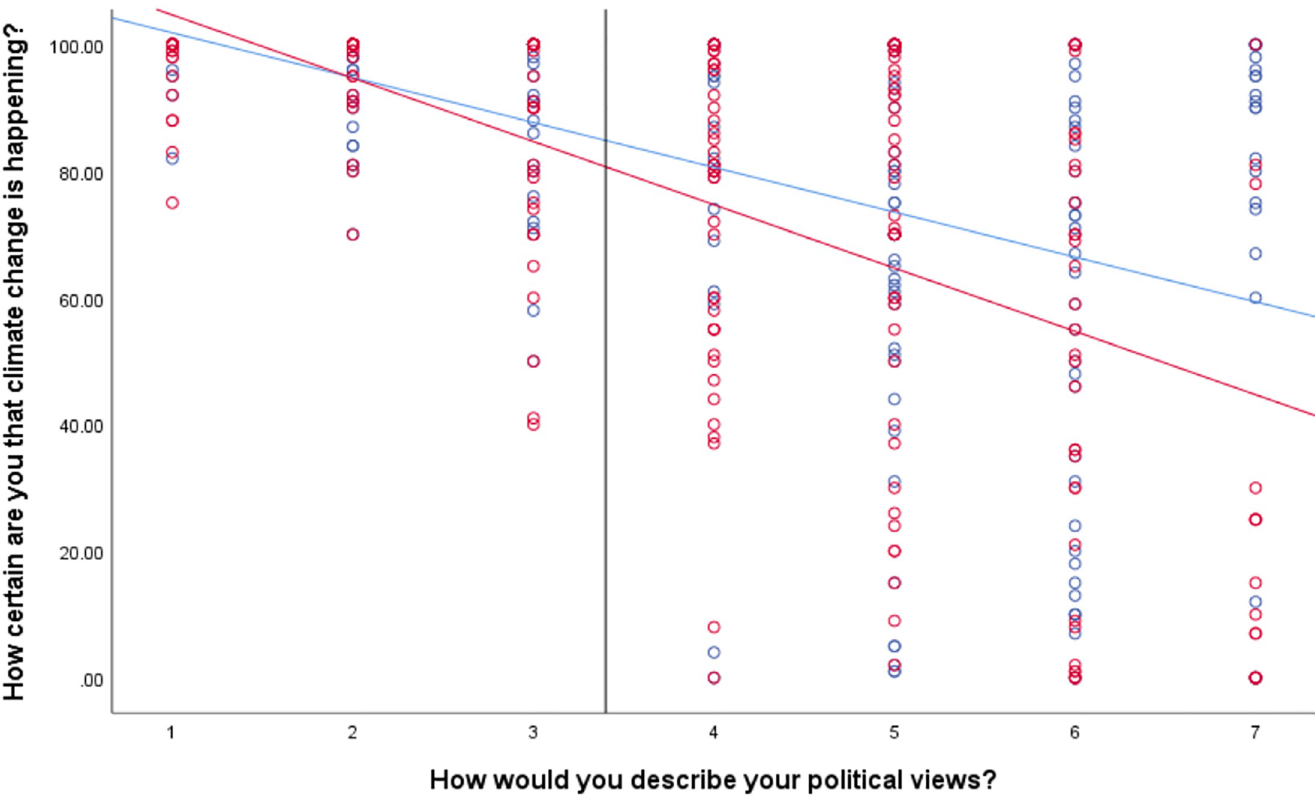
Fig 1. Association between political orientation and certainty that climate change is happening by past (blue) and future (red) temporal framing condition. Solid vertical line represents the Johnson-Neyman value. To the right of this, the differences in certainty ratings by condition are significant.